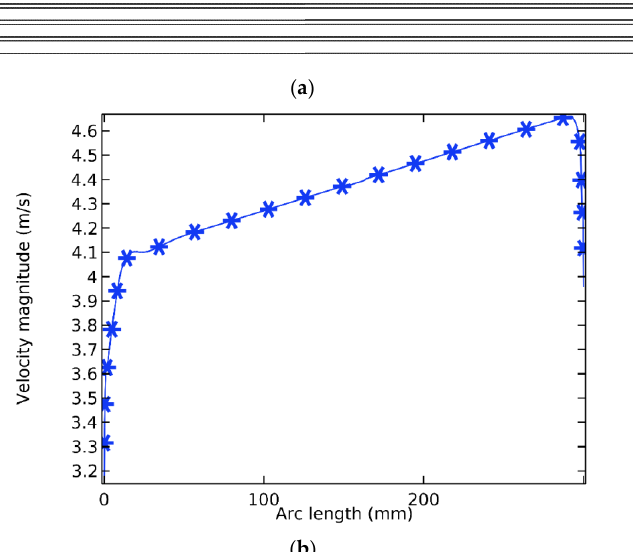
Figure 12. The refrigerant velocity in the microchannel for the straight fin tube model. ( a ) Location of the velocity discussed; ( b ) The velocity field in a microchannel. The comparison between the numerical simulation results and the experimental data is shown in Figure 13 at the evaporative temperature of 10 °C. The experimental temper- ature profile was captured by an infrared thermal camera and then compared with the numerical simulation results. The experimental temperatures were also obtained from the thermocouples. It could be observed that they had similarities at the first four passes, and the refrigerant was superheated at the fifth and sixth passes. From the figure, the deviation between the numerical results and the experimental data was less than 10% at the hottest spot.